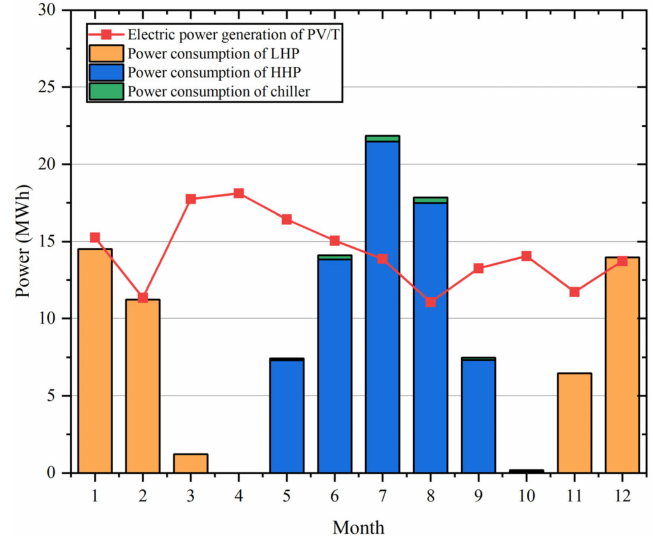
Figure 12. Power production of PV/T and system power